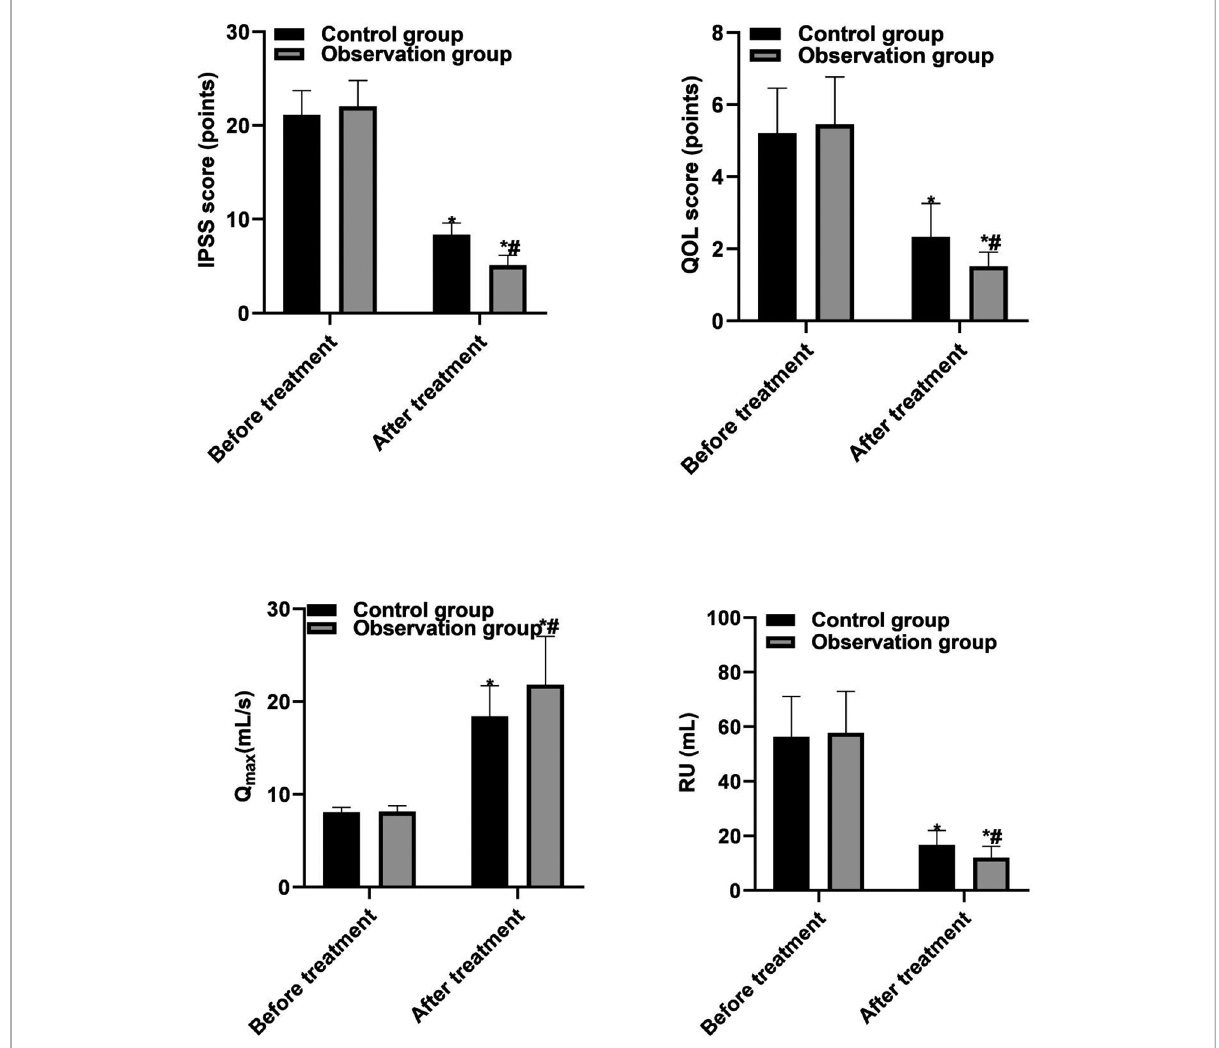
FIGURE 1 Comparison of various ef fi cacy indicators between the two groups. Note: Compared with before treatment, * P <0.05; compared with the control group, # P